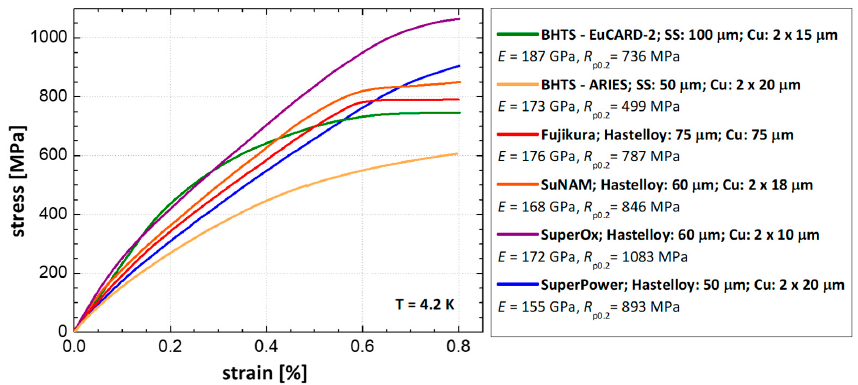
Figure 11. The stress–strain dependence of six industrial REBCO tapes is shown at 4.2 K, with the indication of the Young’s modulus, E, and yield strength, R p0 . 2 , values. Adapted from Ref. [51].